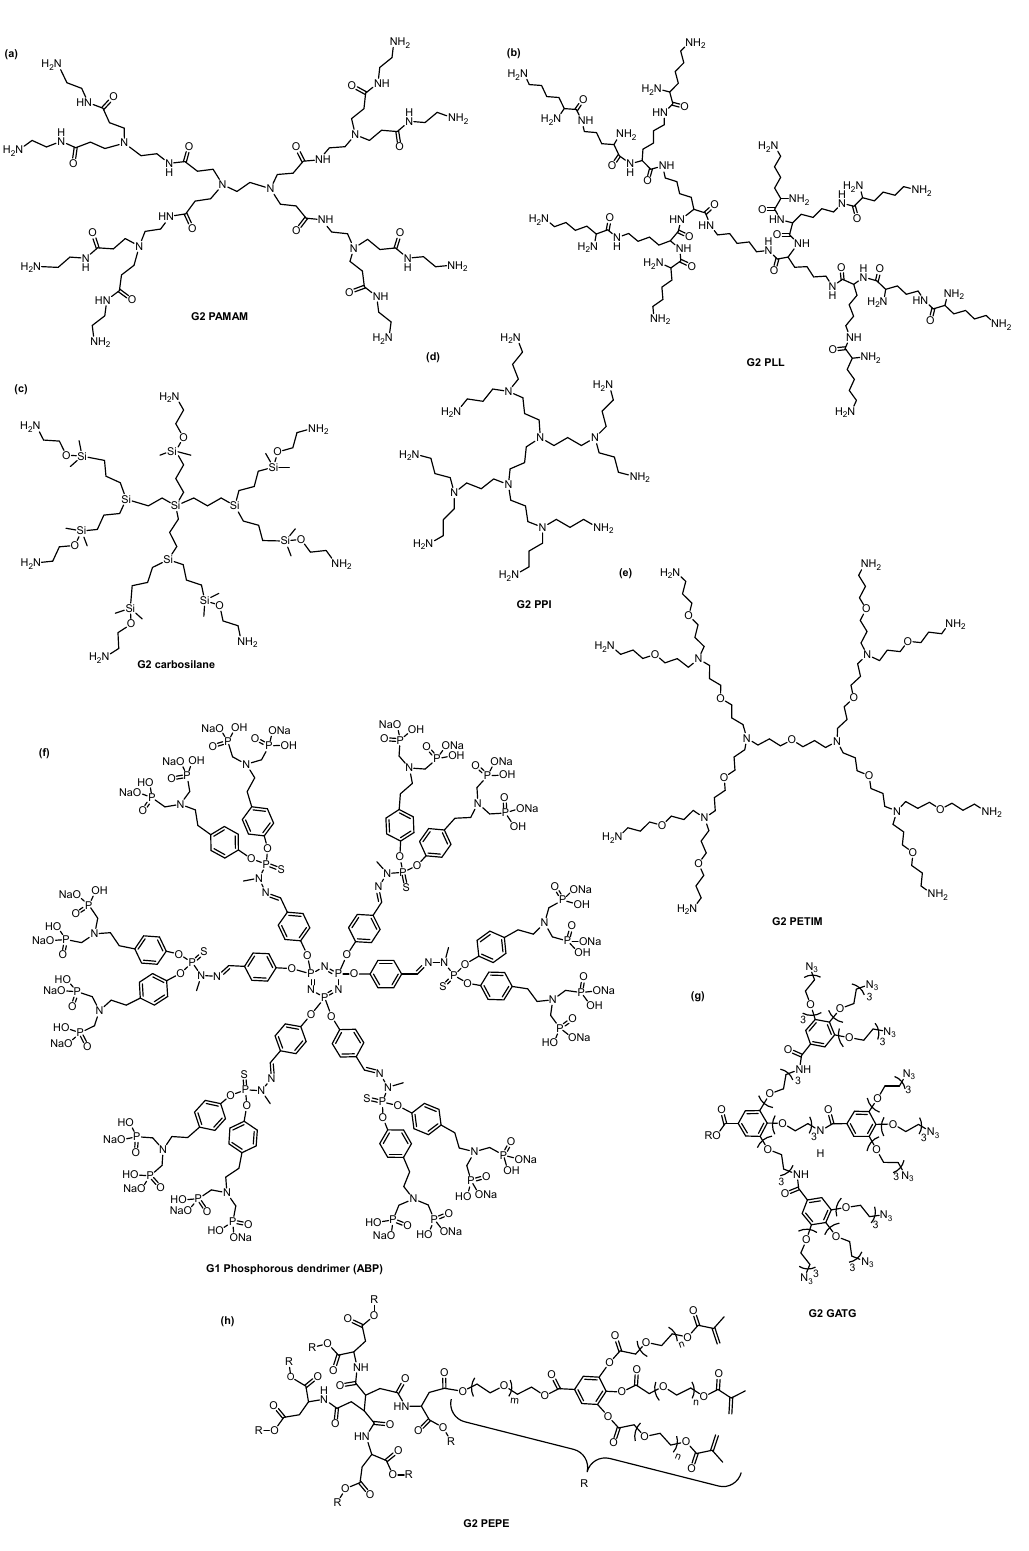
Figure 4. Chemical structure of the most researched dendrimers/dendrons in the biomedical field: ( a ) Generation 2 (G2) poly(amido amine) (PAMAM), ( b ) G2 poly(L-lysine) (PLL), ( c ) G2 carbosilane, ( d ) G2 poly(propylene imine) (PPI), ( e ) G2 poly(ether imine) (PETIM), ( f ) G1 azabisphosphonate- terminated (ABP) phosphorus, ( g ) G2 gallic acid-triethylene glycol (GATG) dendron, and ( h ) poly(ether)-copoly(ester) (PEPE)